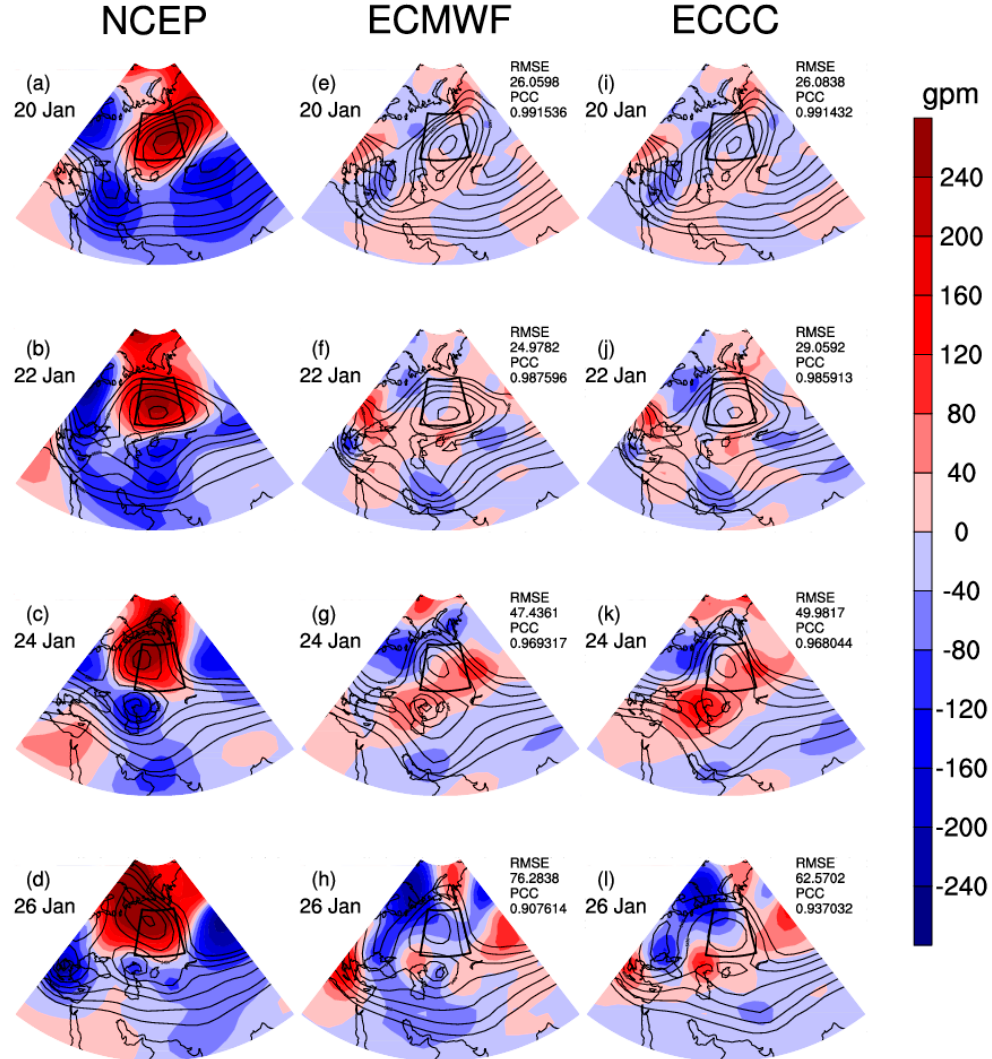
Figure 3. Same as Figure 2, but for the ECMWF and ECCC predictions initialized on 19 January. ( a – d ) the observations, ( e – h ) the ECMWF predictions, ( i – l ) the ECCC predictions from 20 to 26 January 2012. The contour interval is 50 gpm.